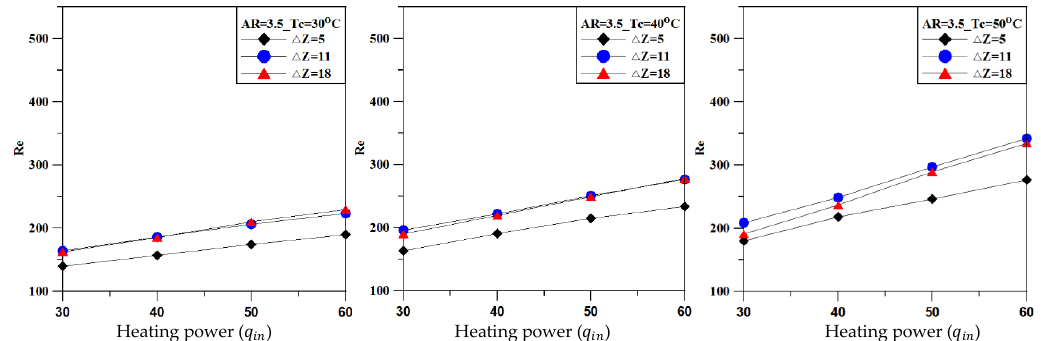
Figure 8. The relationship between the Reynolds number of pipe flow and heating power.